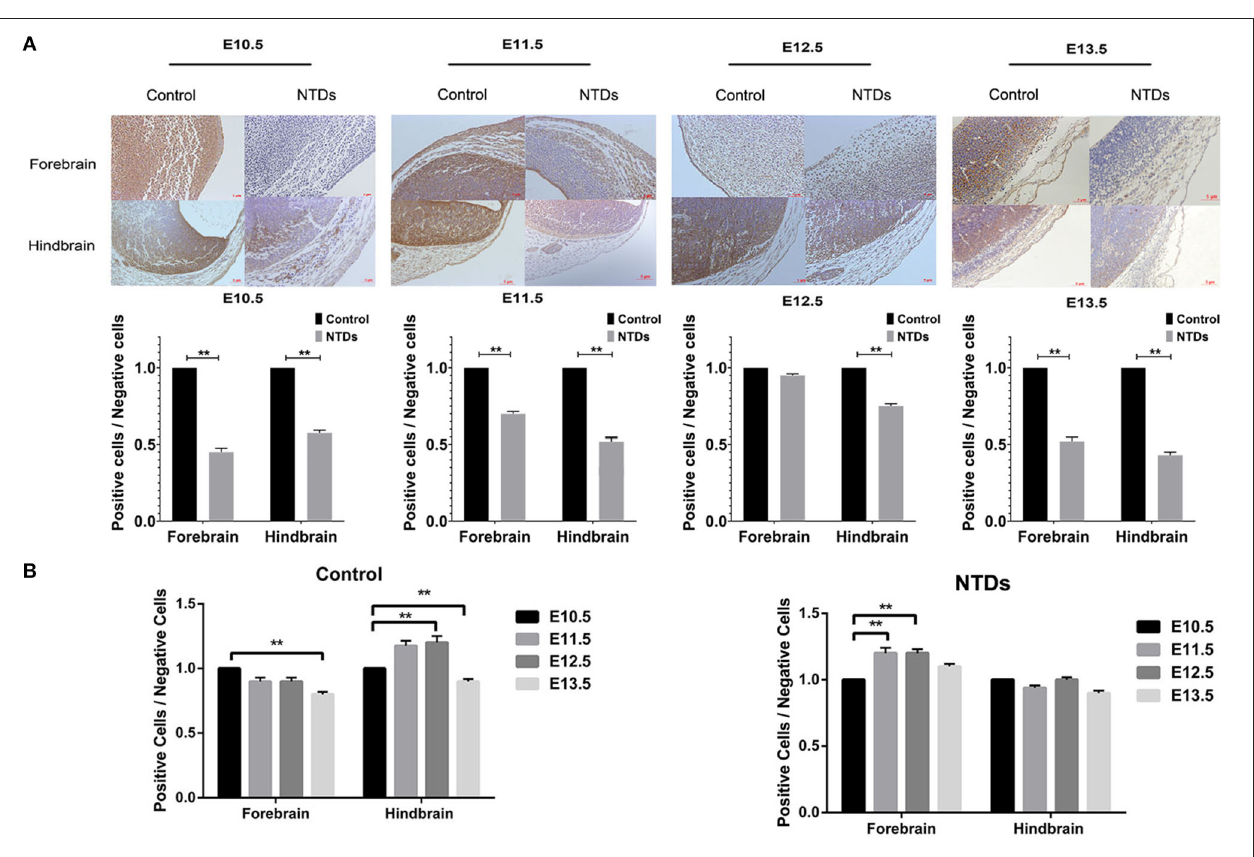
from E 10.5 to E 13.5 ( P < 0.01), while no obvious trend was observed in the hindbrain of the NTDs group ( Figure 2B